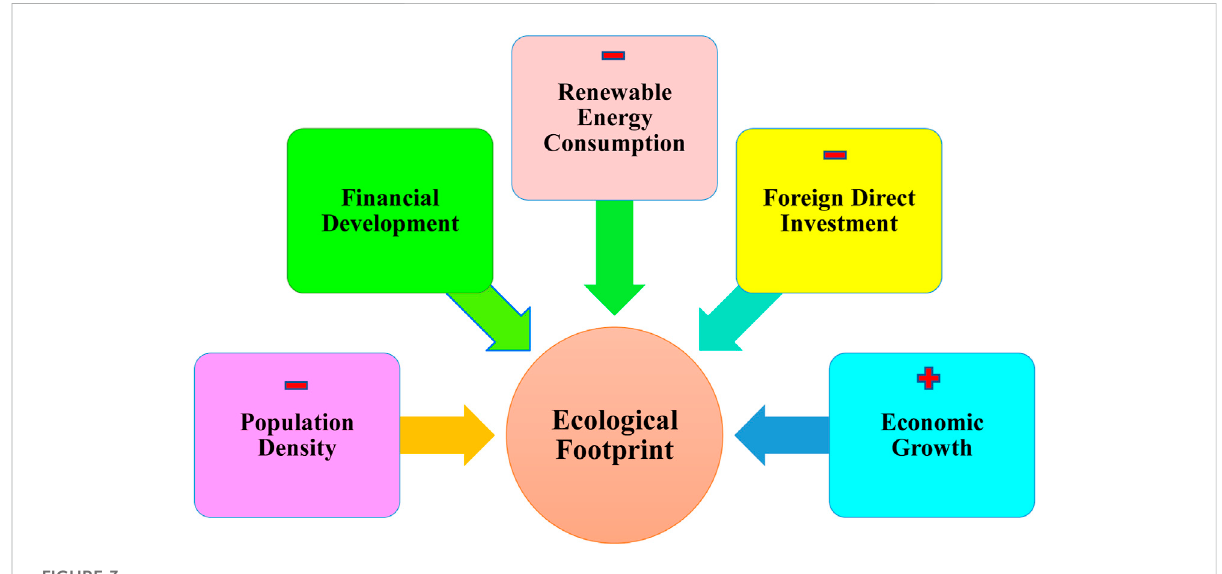
FIGURE 3 Summary of fi ndings from AMG, CCEMG and MMQR.